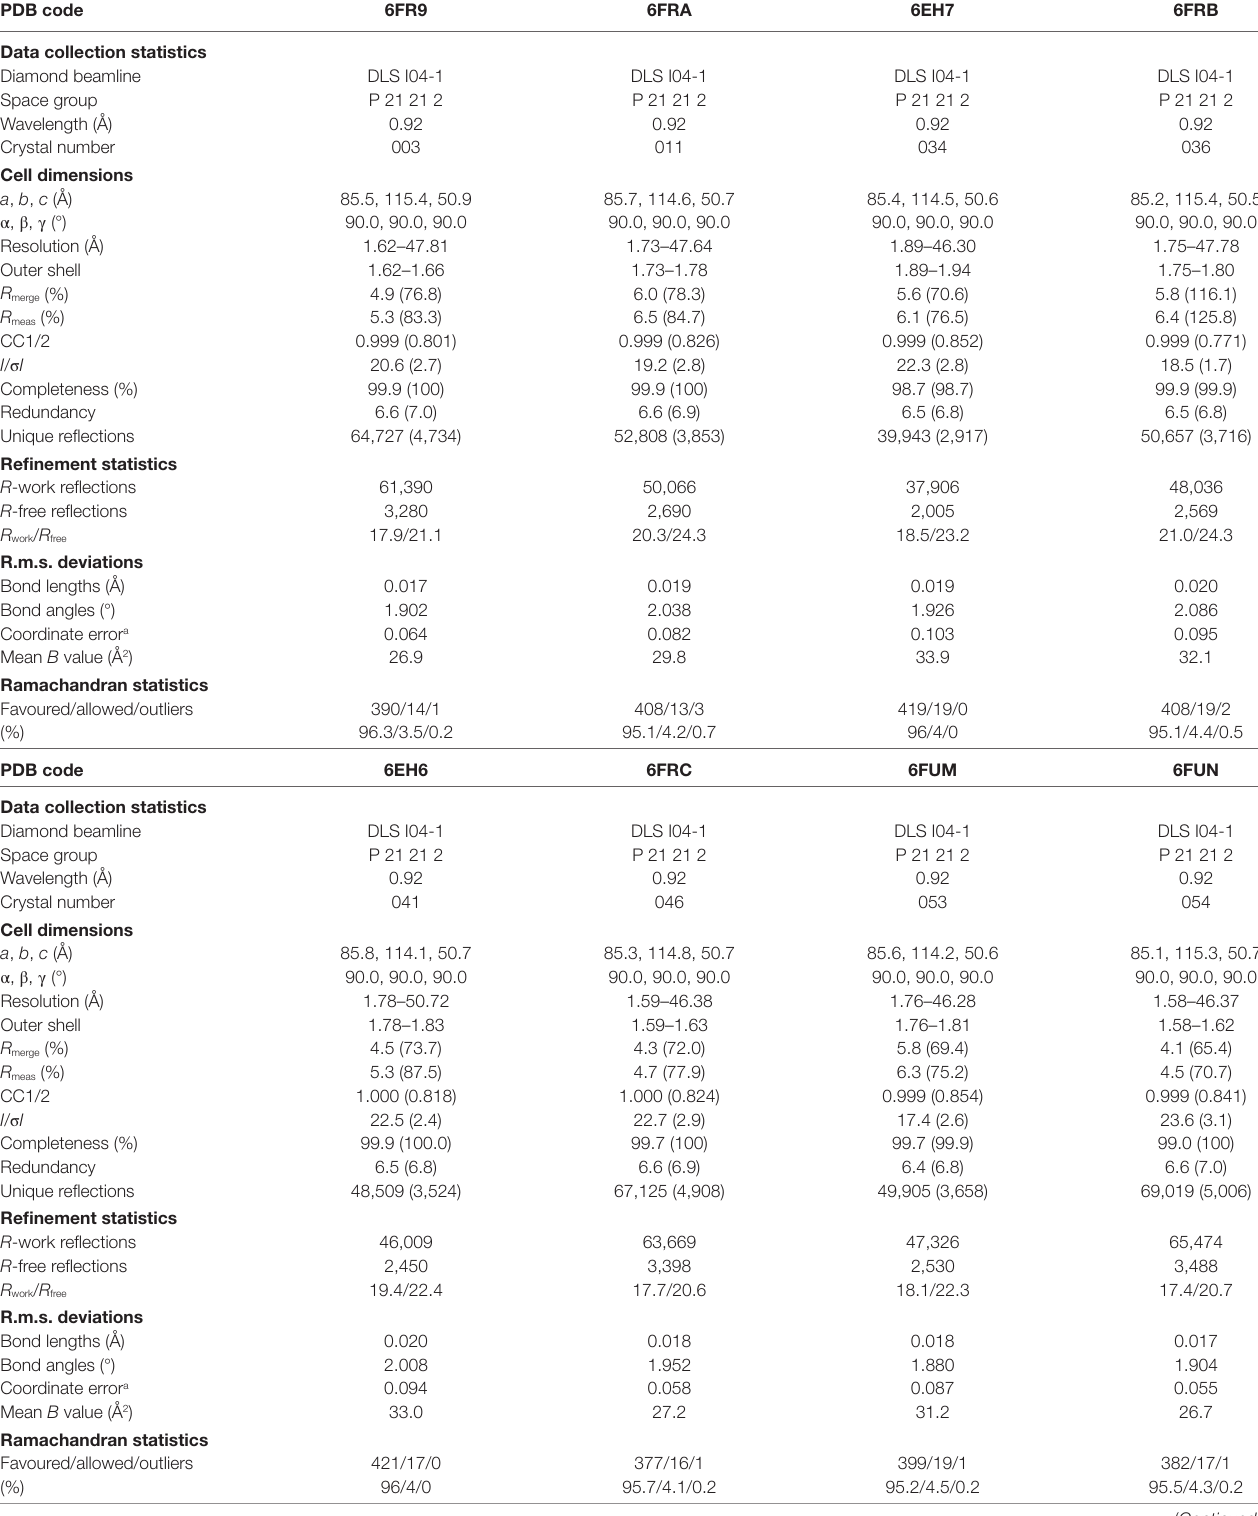
Table 2 | Data collection and refinement statistics for F11 TCR